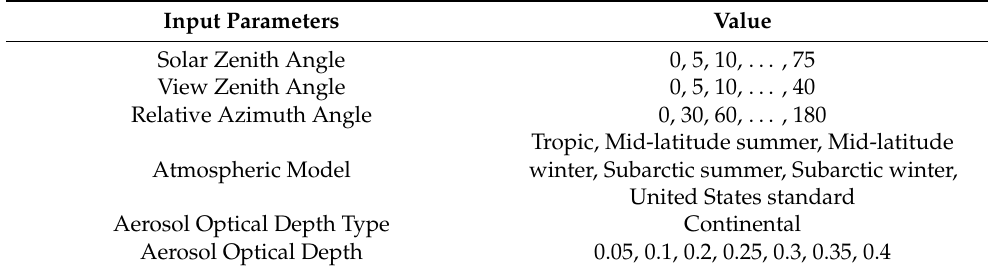
Table 4. Input parameters of the 6S model.